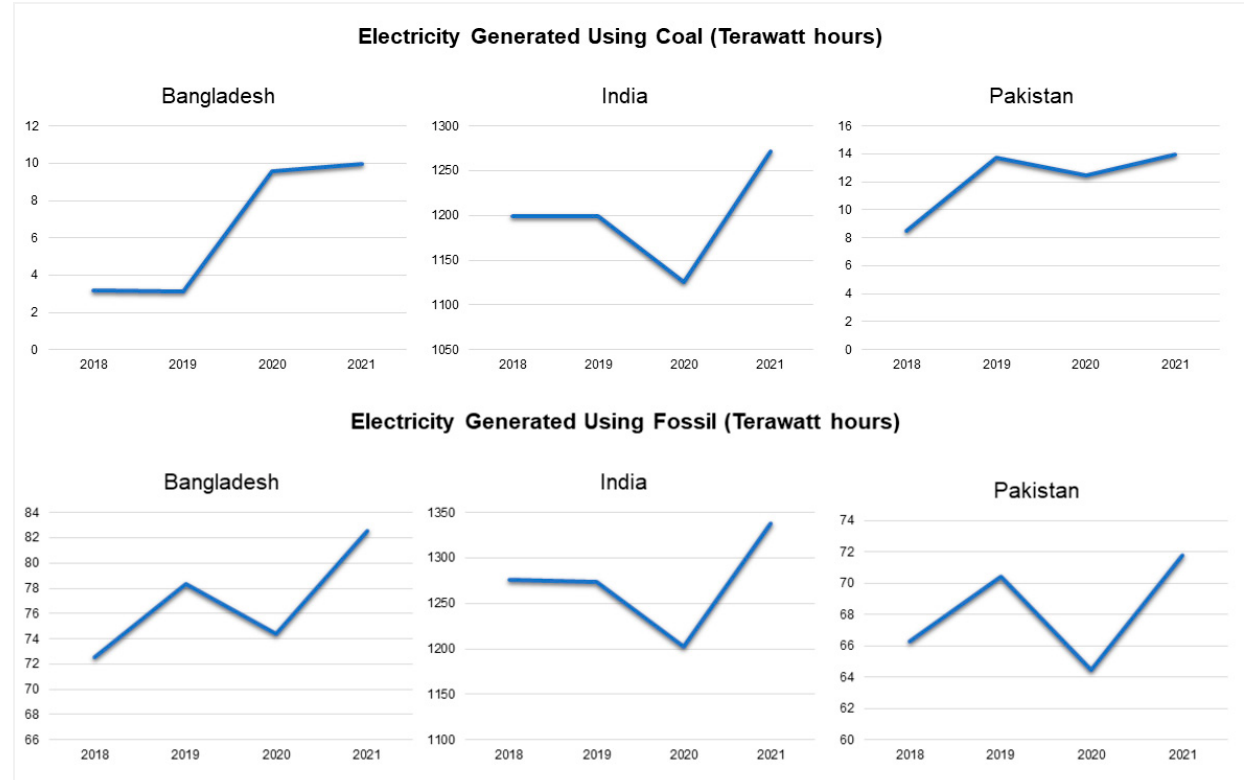
Figure 3. Electricity generated using coal and fossil in Terawatt hours (2018–2021) [43].